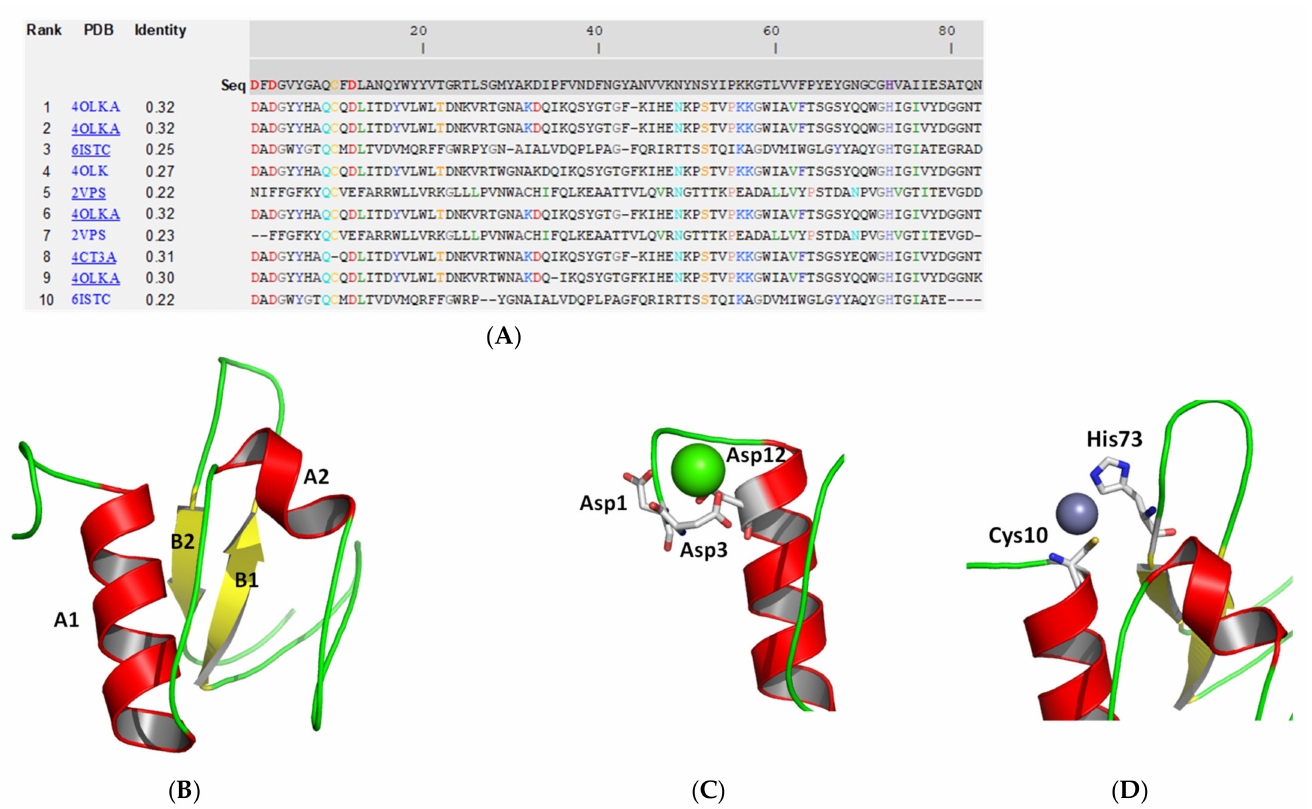
Figure 5. Structure prediction of the CHAP domain using the I-TASSER approach [26,27]. ( A ). Ten best threading templates that were used by I-TASSER. Templates were identified by LOMETS threading programs [32] from the PDB library. Conserved residues are colored. Coloring scheme is based on the property of amino acids, where polar are brightly colored while non-polar residues are colored in dark shade. The column ‘identity’ is the percentage sequence identity of the templates in the threading aligned region with the query sequence. The top 10 alignments reported above (in order of their ranking) are from the following threading programs: 1, MUSTER; 2, FFAS-3D; 3, SPARKS-X; 4, HHSEARCH2; 5, HHSEARCH I; 6, Ne ff -PPAS; 7, HHSEARCH; 8, pGenTHREADER; 9, PROSPECT2; 10, PRC. ( B ): Ribbon diagram of CHAP domain. α -Helices are colored red and β -strands yellow. ( C ). The predicted calcium binding residues. Calcium is shown as a sphere. ( D ). The predicted zinc binding residues. Zinc is shown as a sphere. The drawings were created using